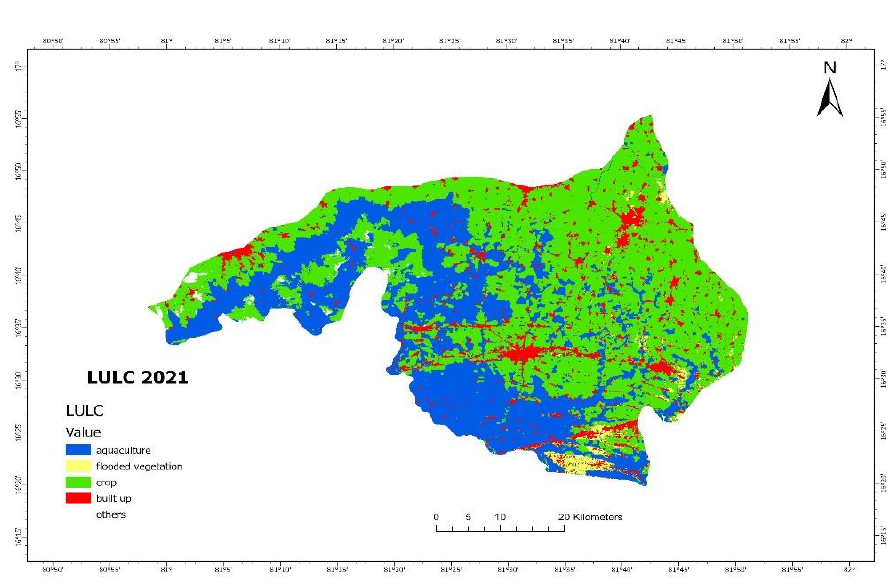
Figure 2. Study area.